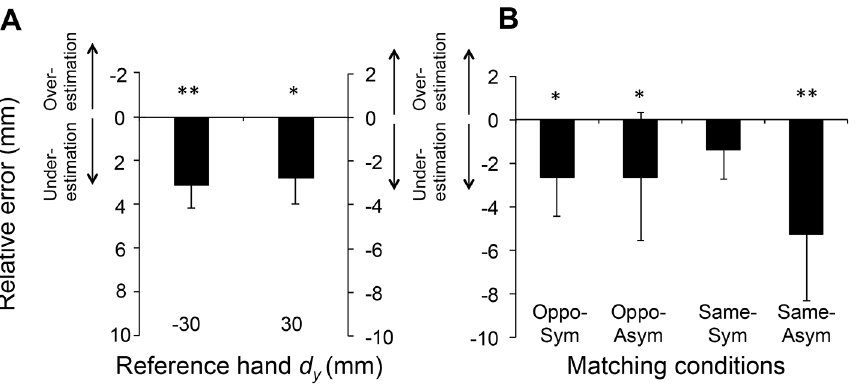
Figure 6. Relative error: averaged data. Relative errors were compared across reference hand d y s and matching conditions (panels A and B, respectively). For Panel A, the relative errors with respect to the under- and over-estimation are shown in the same format as Figure 5. For Panel B, relative error values were pooled across non-collinear d y . For both panels, data are averages of all subjects within a given group ( 6 SE). Note that relative error from the collinear condition was excluded from statistical analysis across matching conditions (see text for more details). Single and double asterisks denote a statistically significant difference from zero ( p , 0.05 and 0.01, respectively). Note that, since the opposite signs of relative error were defined as under- and over-estimation, the sign of relative error when reference hand thumb was placed lower ( d y = 2 30 mm) is inverted for the relative error pooled across the four conditions (Panel B) for graphical purpose only such that the negative relative error always denotes underestimation.